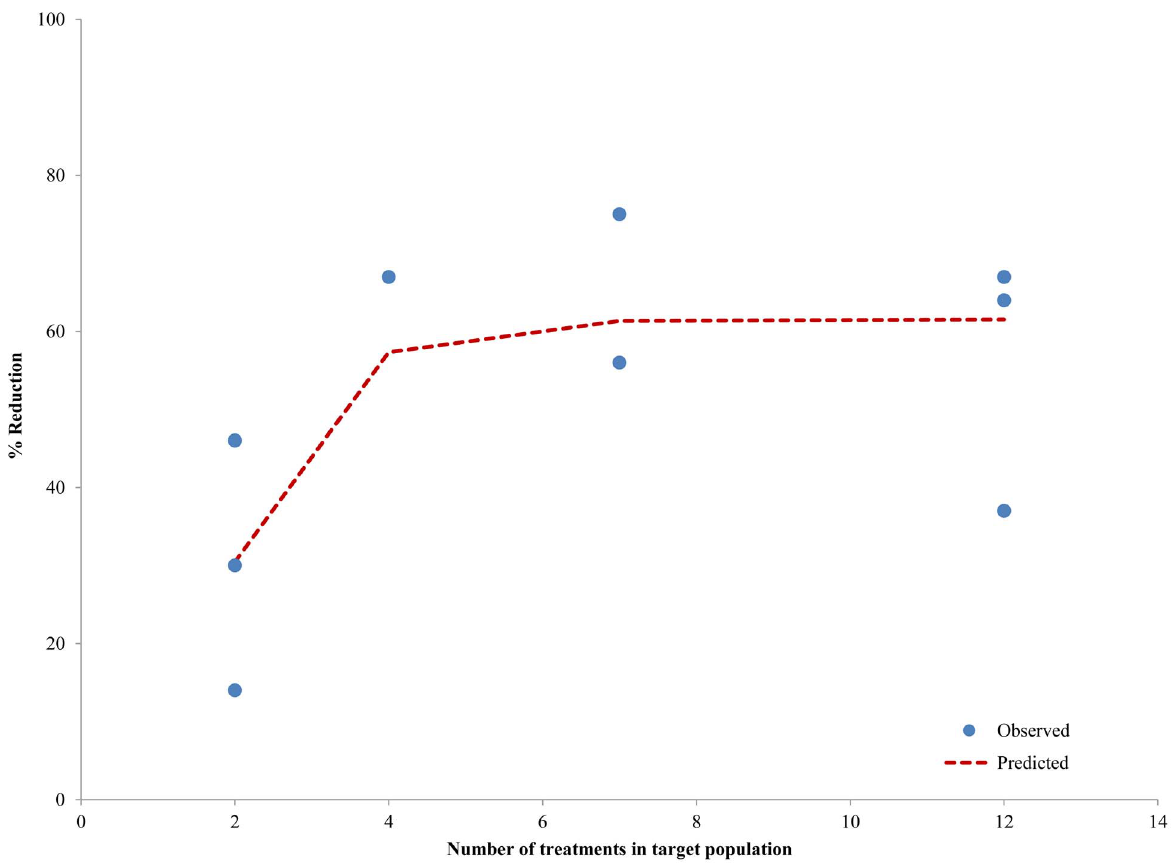
Figure 2. Empiric observations defining the relationship between number of treatments and % reduction in hydrocele prevalence 1 year later.